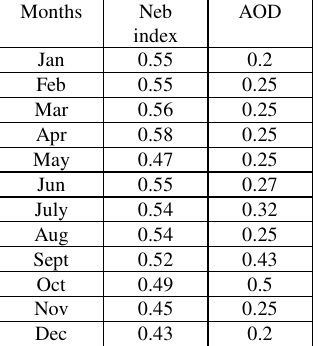
Table 2. Monthly Nebulosity Index (Zain-Ahmed et al.